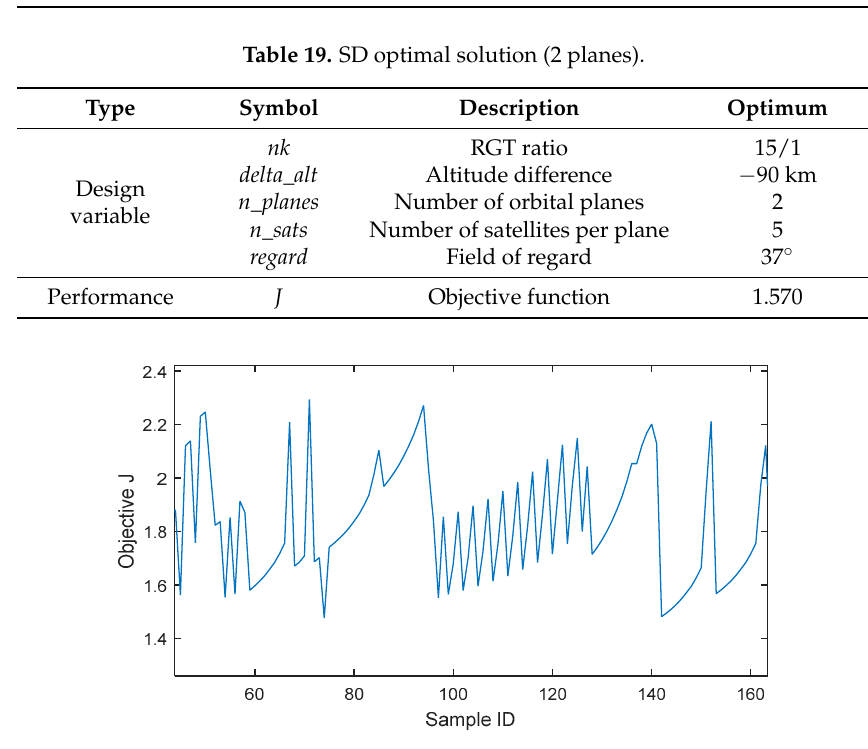
Figure 15. Illustration of objective ( J ) space for discrete samples.